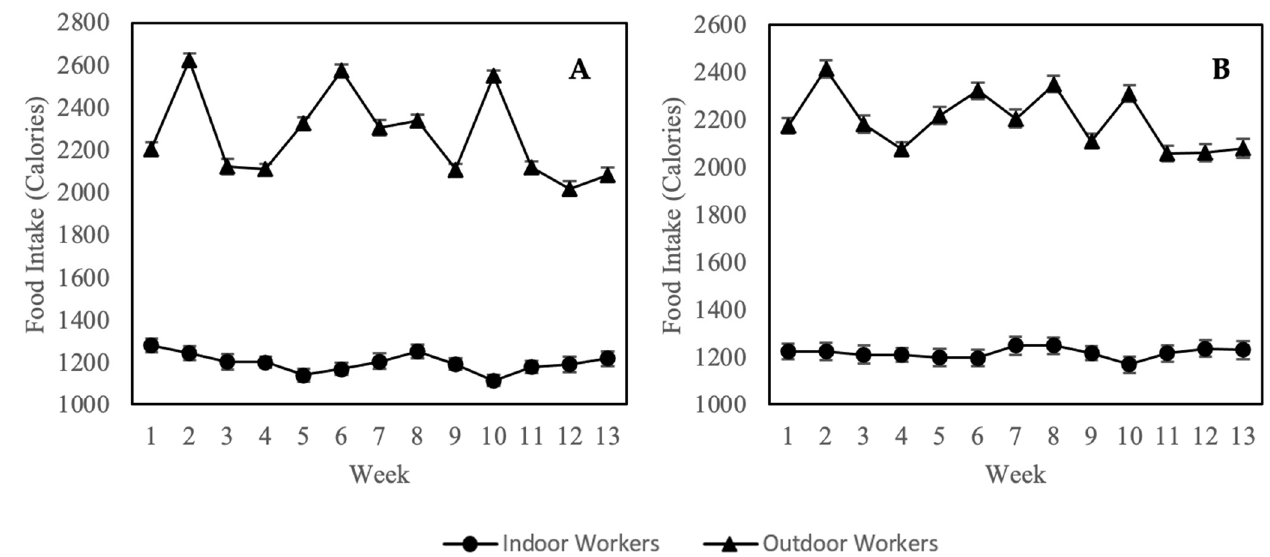
Figure 3. Change of calorie intake between indoor and outdoor workers over 13 weeks period in Cycle 1 ( A ) and Cycle 2 ( B ). Values were expressed as means ± standard error.